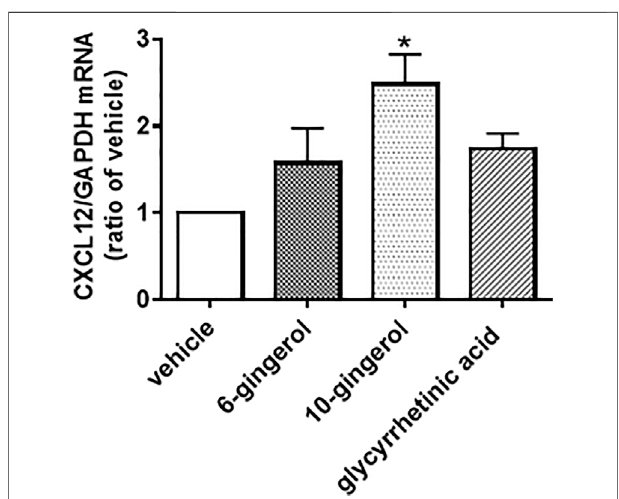
FIGURE 5 | Effect of components of Hangeshashinto (HST) on the expression of CXCL12 mRNA in human oral keratinocytes (HOKs). HOKs were scratched and treated with vehicle, 6-shogaol (1 µM), 10-gingerol (10 µM), or glycyrrhetinicacid(10 µM)for 48 h. mRNAexpressionwas determinedby RT-qPCR. Data are expressed as the mean ± SEM. (bars). * indicates p < 0.05 compared with vehicle. Bonferroni ’ s comparison test following ANOVA.